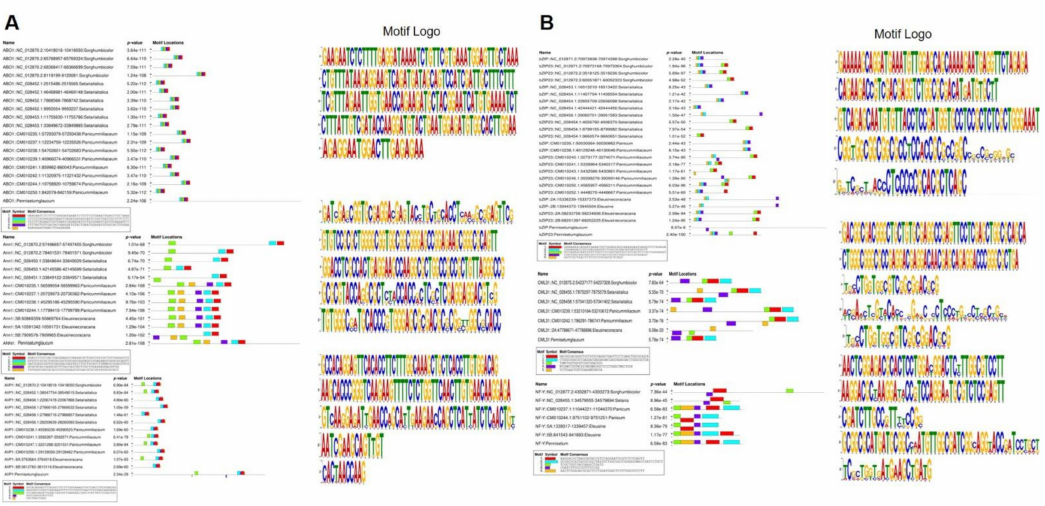
Figure 4. ( A ) Distribution and sequence of common conserved motifs of drought gene in pearl millet, sorghum, foxtail millet, proso millet, and finger millet. Clusters of motifs observed in similar order in different millets. Different colored boxes indicate different motifs. ( B ) Relatively less-conserved clusters of motifs observed in CML, Nf-Y, and bZIP genes among millet